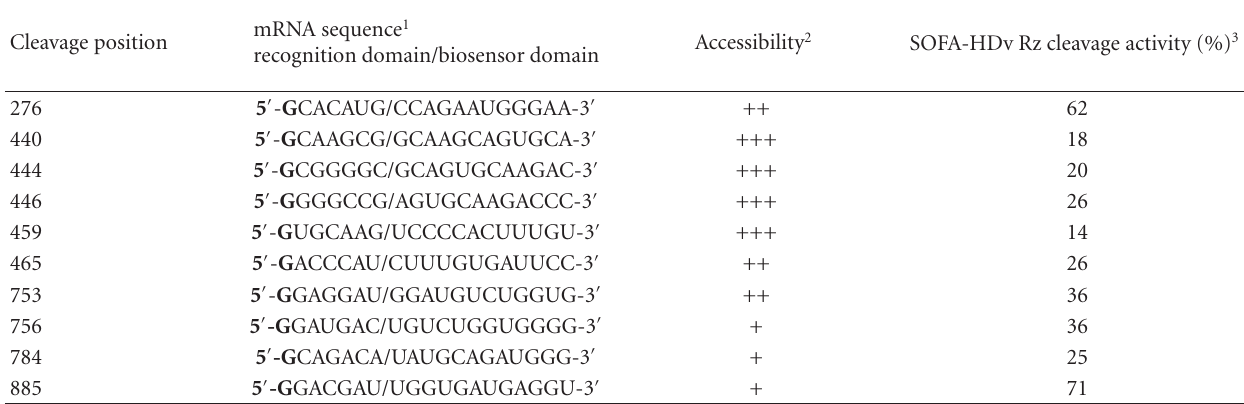
Table 1: Determination of the most potential cleavage sites within APP